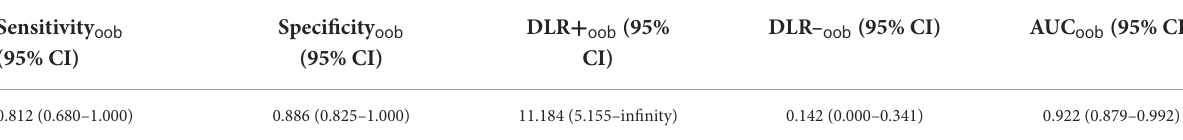
TABLE 3 Results of the bootstrapping procedure to assess the out-of-bag performance of the RVA RT-qPCR optimal cutoff point (log10 viral load of 9.171). Sensitivity